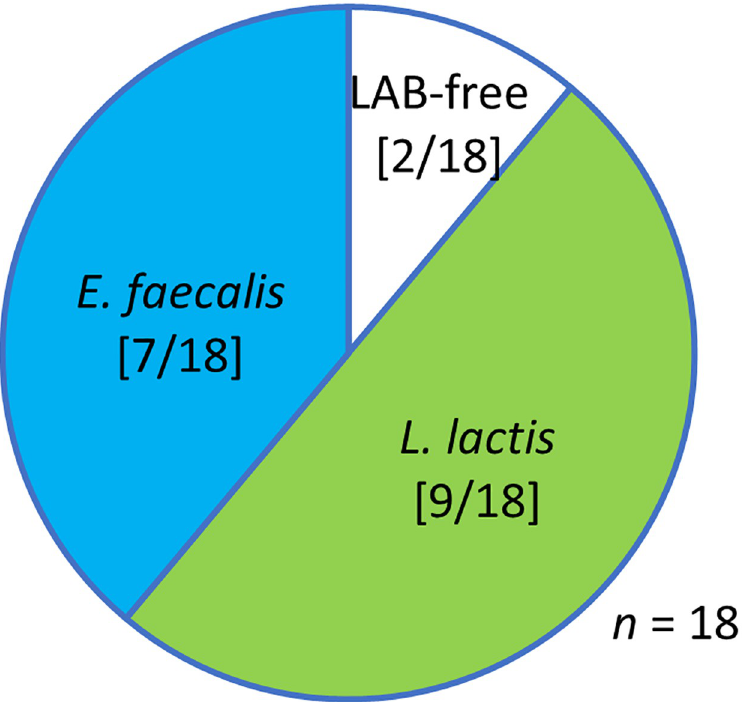
Fig 9. Discovery of LAB infection in R . pedestris in South Korea. Infection frequencies of LAB in the wild populations of R . pedestris in South Korea. The number of infected insects per number of all insects examined is shown in brackets.